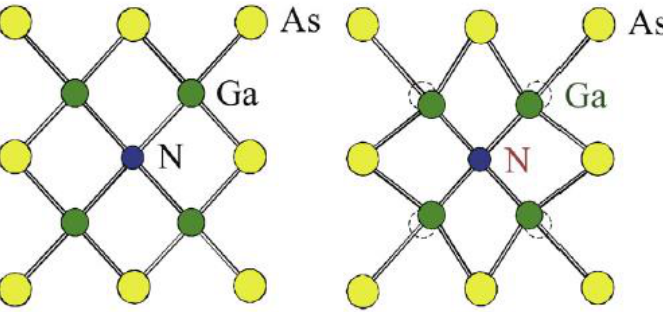
Figure 1. The local static atomic displacements of Ga atoms from their virtual average lattice position introduced by a N atom [1]. Reprinted with permission from [1]. Copyright 2015, Elsevier.